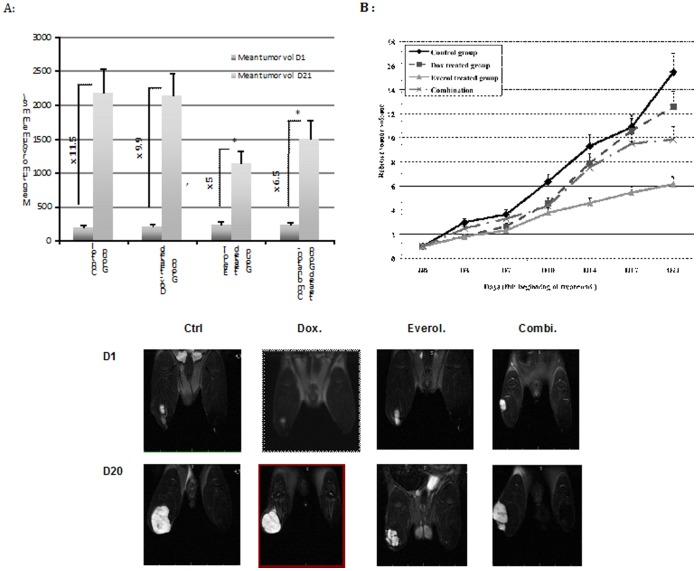
Response of established chondrosarcoma model to each treatment.A, Mean tumor volume evolution between day 1 and day 21 (fold expansion are expressed beside each group). B:Time course of mean tumor volume (expressed in fold expansion compared to day 1). The results indicated that everolimus as single agent significantly (p<0.01) slowed down chondrosarcoma progression; the combination of doxorubicin to everolimus showed an additive effect in comparison to doxorubicin alone, but was less efficient than everolimus alone. C: Longitudinal growth of tumor of one rat from each group monitored by MRI.